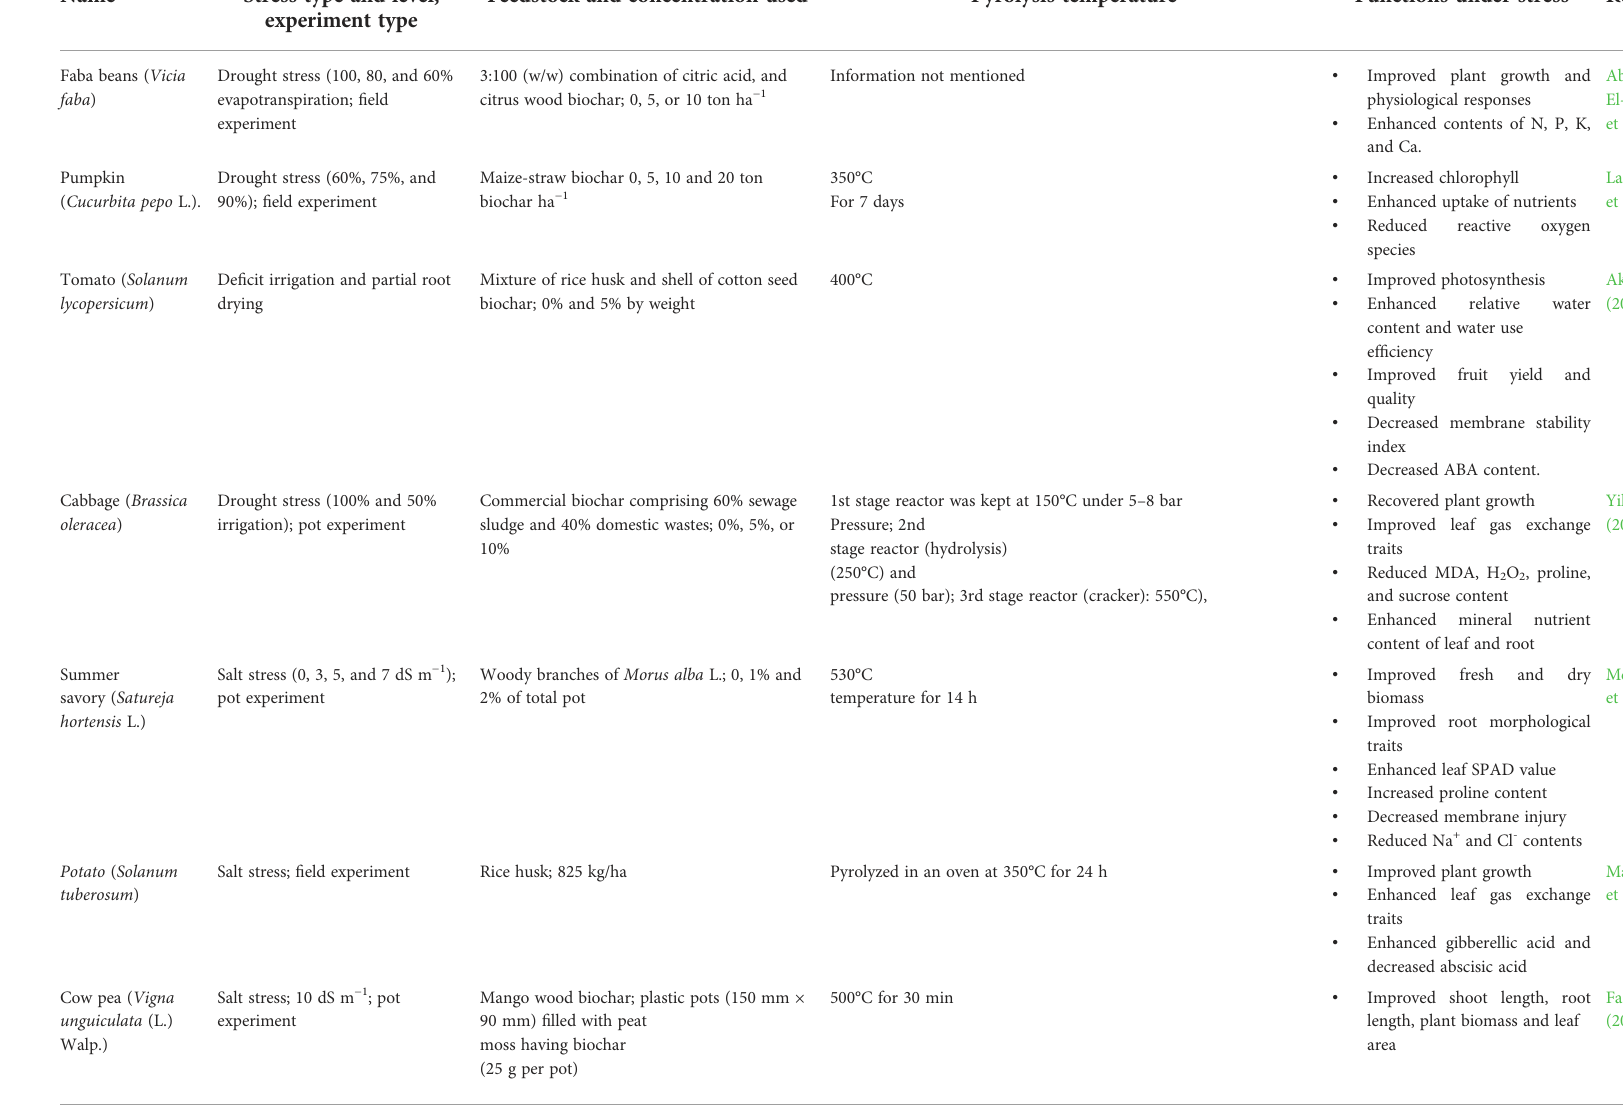
TABLE 1 The ameliorative effect of biochar on horticultural crops grown under different environmental